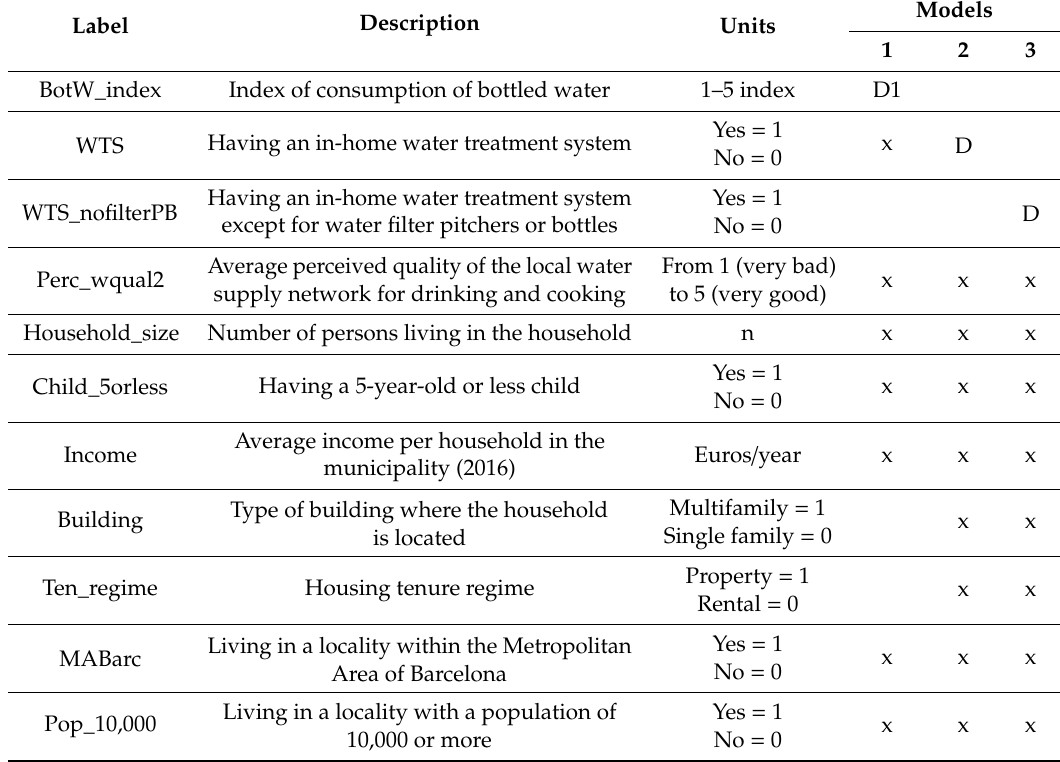
Table 1. List of dependent and sociodemographic